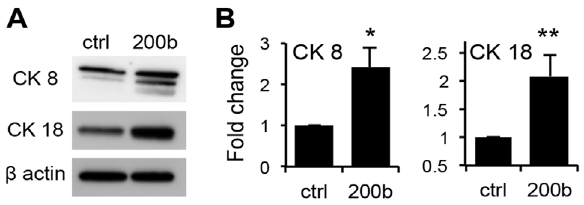
Figure 4. miR-200b promotes differentiation of PC-3 cells. (A). CK 8 and CK 18 were analyzed by western blot of total protein lysates from PC3-ctrl and PC3 miR-200b cells. (B) Quantitative analysis of the experiment (A) with Image J software. The graph represents data average of two independent experiments. *, p # 0.05 and **, p , 0.01 by Student’s